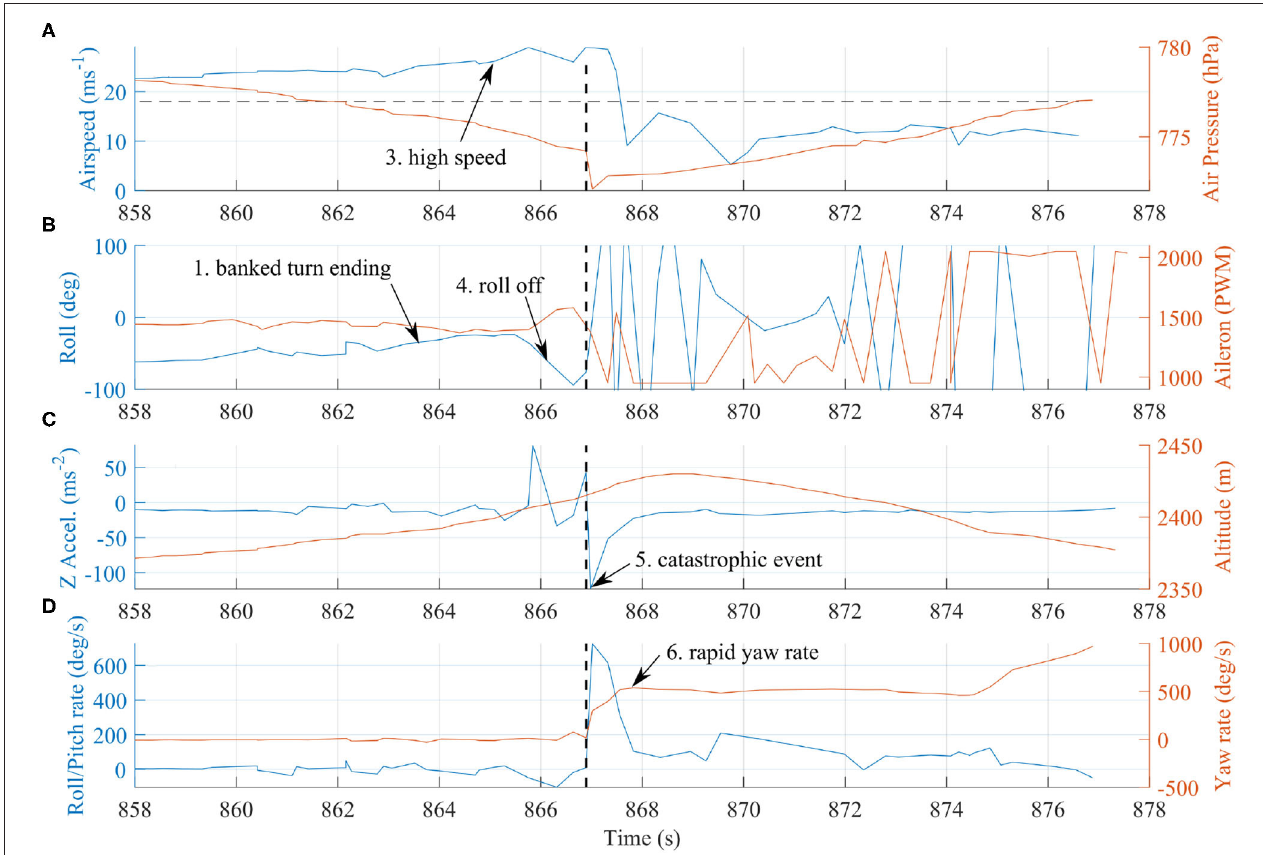
FIGURE 9 | Indicative signals from the telemetry log file of flight C for the final 20s of transmission. Signals (A) airspeed and air pressure, (B) roll angle and aileron input command, (C) vertical acceleration and altitude, and (D) roll, pitch, and yaw angular rates, have been plotted against a common time-axis. A catastrophic event occurs at 867s followed by a rapid ( > 1Hz) spin. See Table 3 for further details of the order of events.